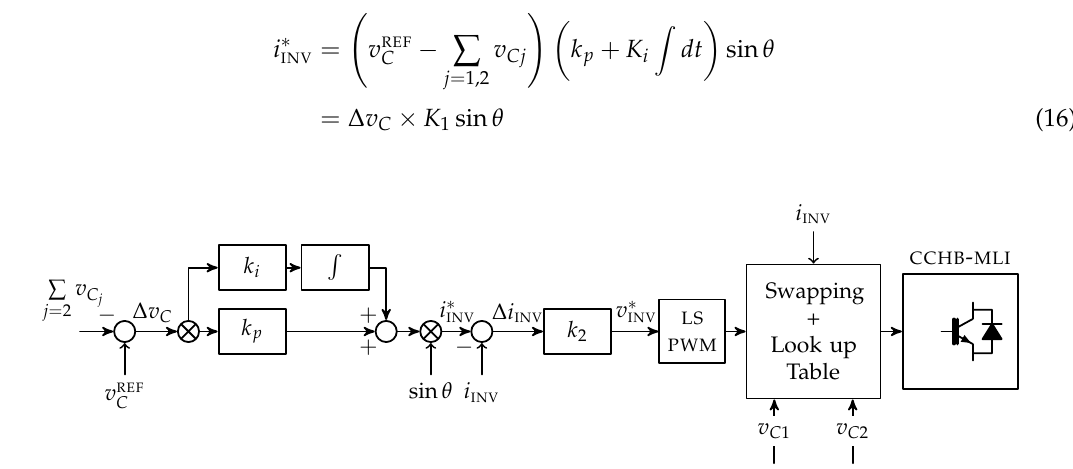
Figure 9. Block diagram of voltage and current